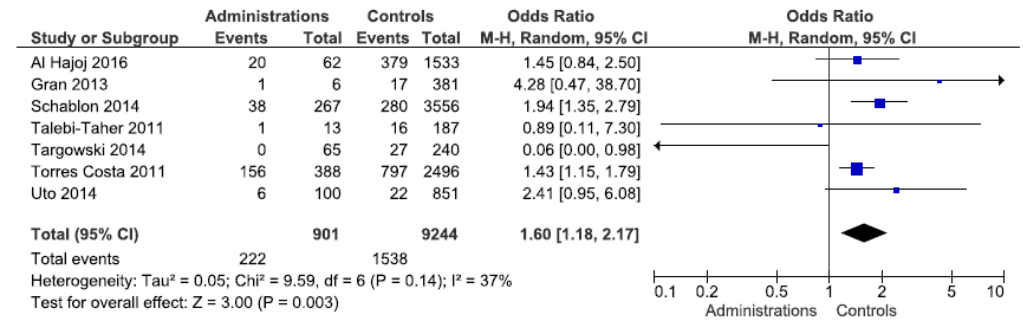
Figure 2. Forest plot of the LTBI prevalence in administrative employees by IGRA in low incidence